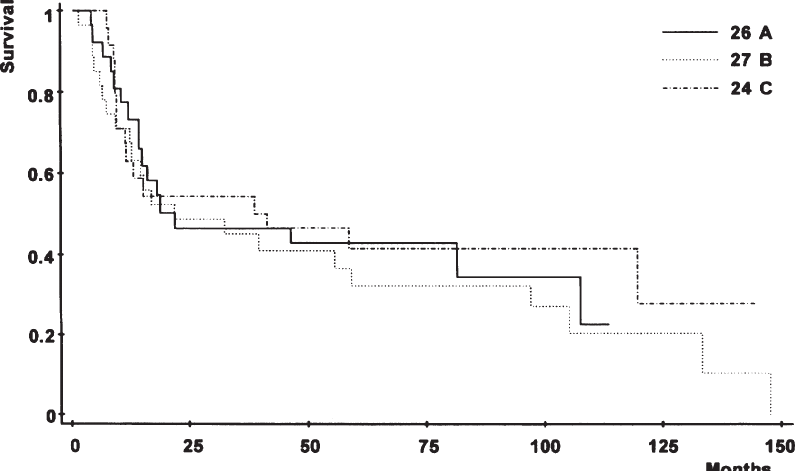
Fig. 2. Crude survival for Ki-67 expression. Patients were divided into three groups; group A: LI 11–24%, group B: LI 25–38% and group C: LI 39–60%. No significant difference in crude survival was found between the three